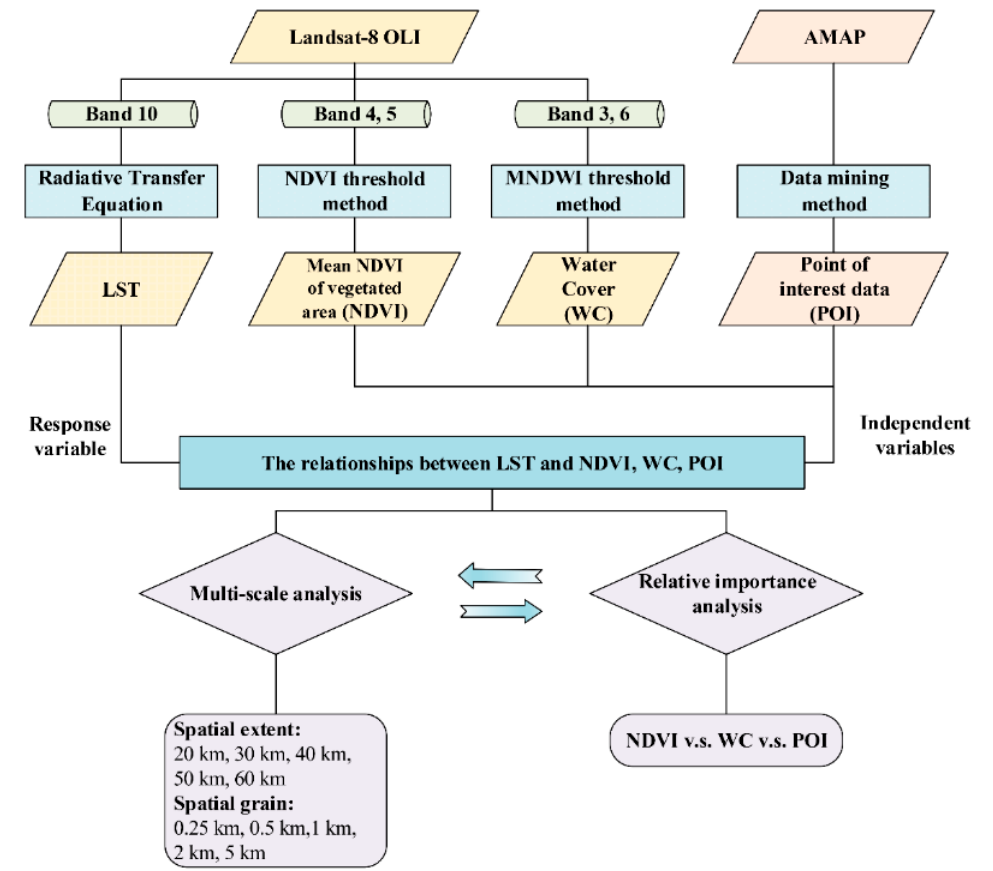
Figure 2. Flowchart showing the procedures for data acquisition and methodology.